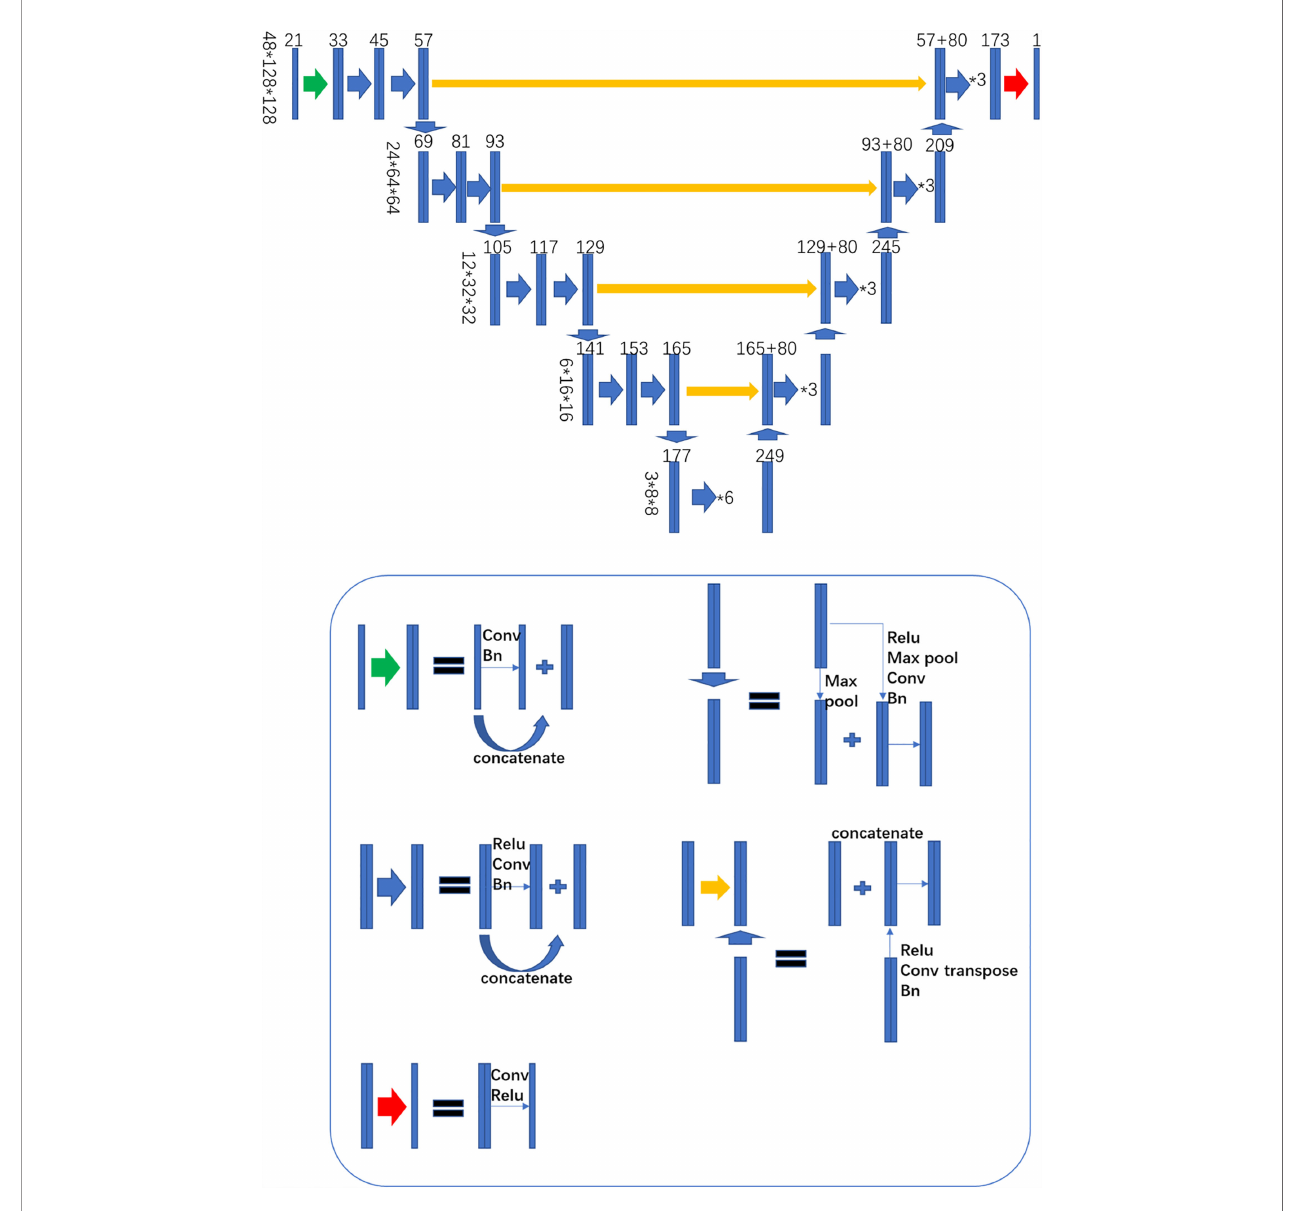
FIGURE 1 | 3D Dense-U-NET